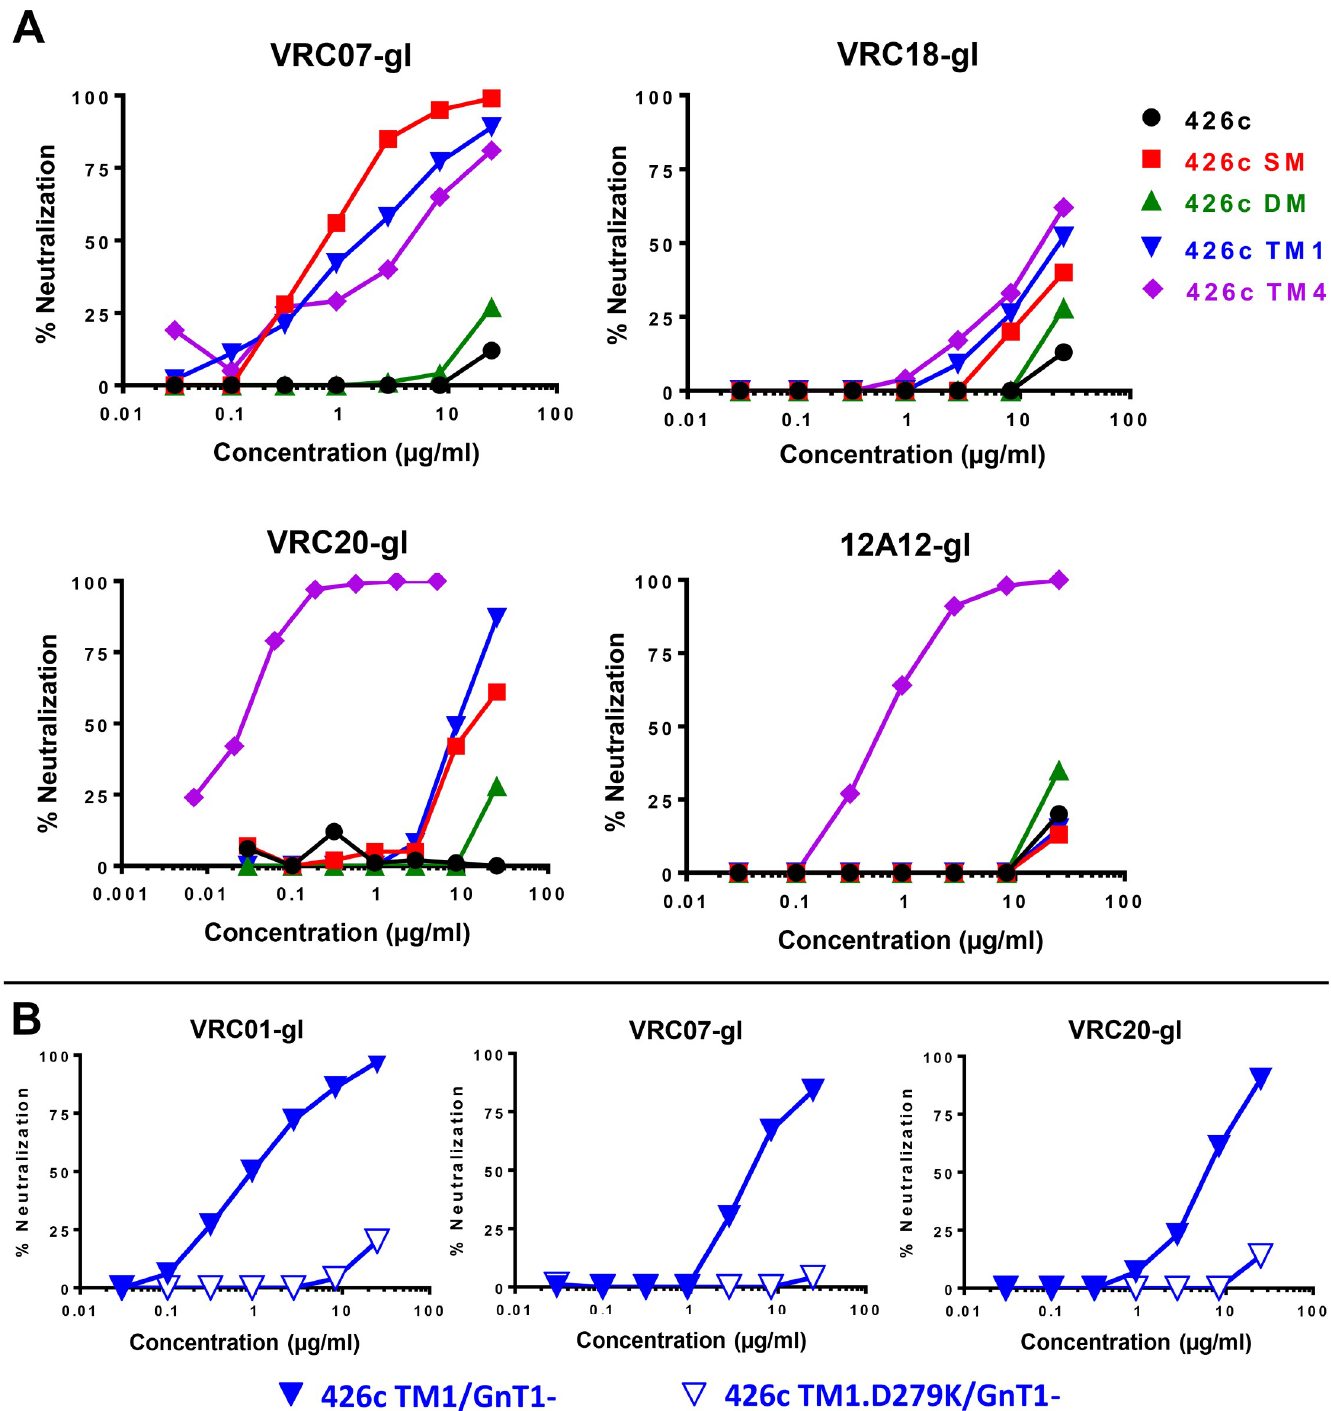
Fig 2. Detection and epitope mapping of neutralization by germline-reverted forms of VRC01-class bnAbs. (A) Germline reverted forms of the indicated bnAbs were assayed in TZM-bl cells against Env-pseudotyped viruses 426c, 426c.SM (N276D), 426c.DM (N260D.N463D), 426c.TM1 (N276D.N460D.N463D) and 426c.TM4 (S278R.G471S.N460D.N463D) produced in 293S GnT1 - cells. (B) Germline-reverted forms of VRC01, VRC07 and VRC20 were assayed in TZM-bl cells against 426c. TM1 and 426c.TM1.D279K produced in 293S GnT1 - cells.